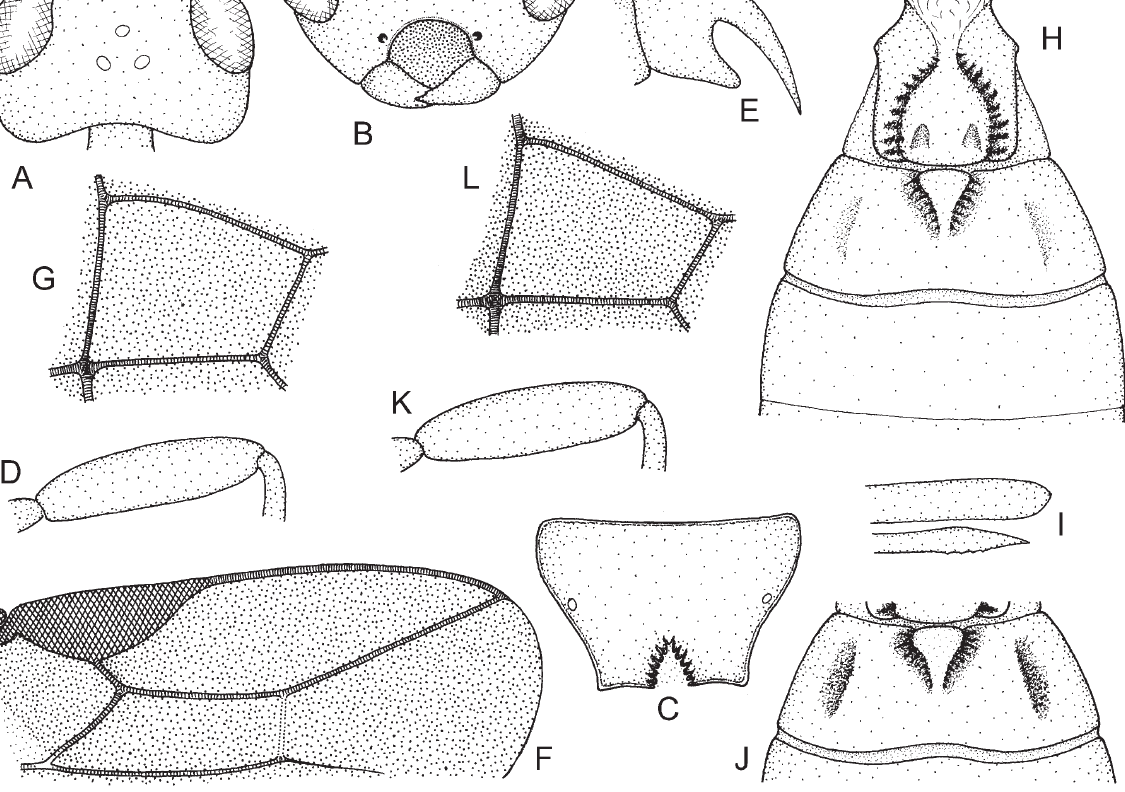
Fig. 22. Bracon ( Foveobracon ) megapterus Wesmael, 1838 (A-I: ♀ lectotype, J-L: ♀). A . Head in dorsal view. B . Head in frontal view. C . Propodeum. D . Hind femur. E . Claw. F . Distal part of right forewing. G . First discal cell of right forewing. H . Tergites 1-3. I . Hind end of ovipositor apparatus. J . Second tergite. K . Hind femur. L . First discal cell of right